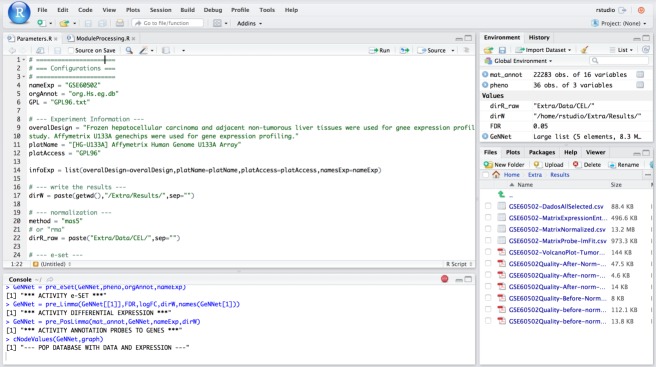
Example of access mode to RStudio where it is possible to modify the predefined functions.